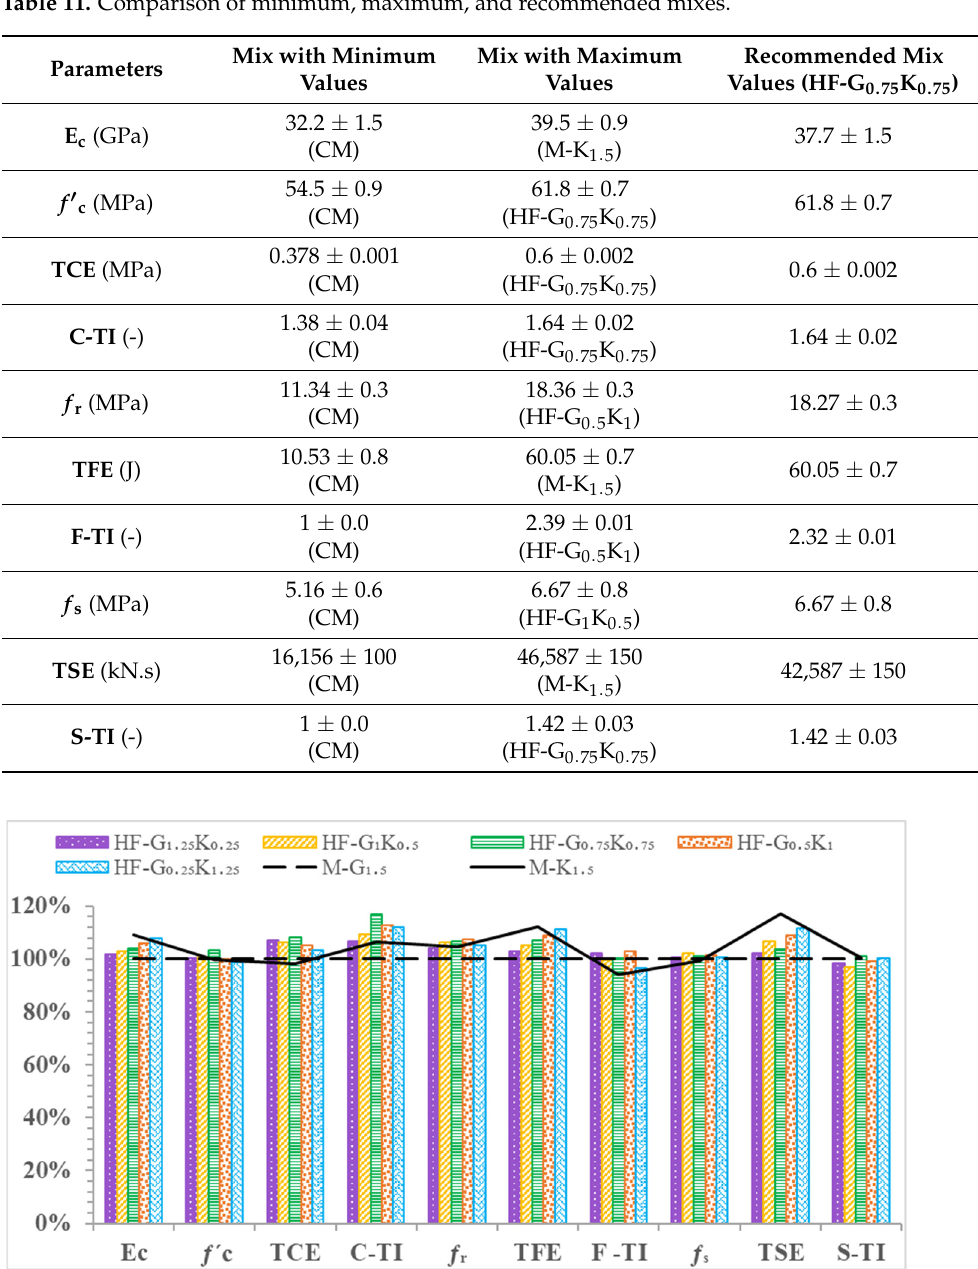
Figure 13. Comparison of the properties of HPHFRC and HPFRC.